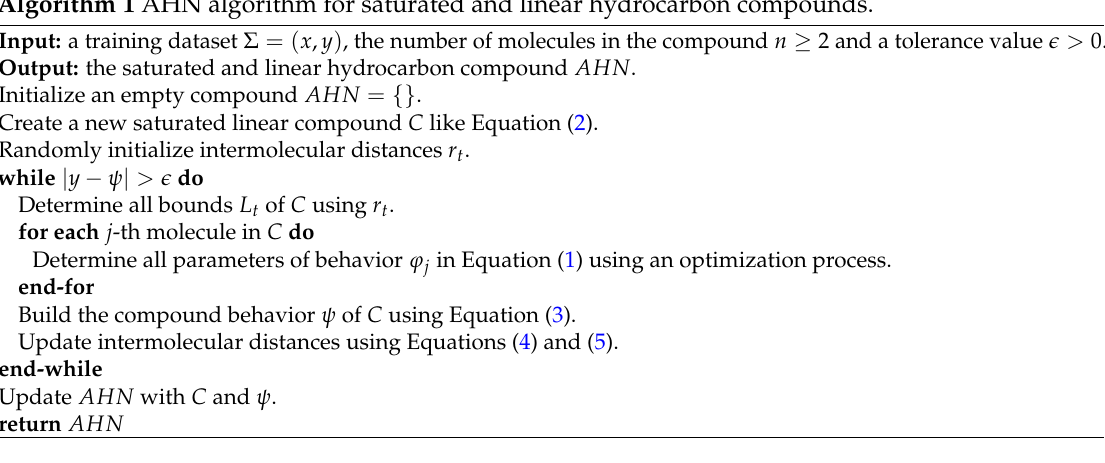
Figure 1. Structure of an artificial hydrocarbon network using saturated and linear chains of molecules [29]. For this work, the topology of the proposed classifier considers just one hydrocarbon compound (see Section 4). Algorithm 1 AHN algorithm for saturated and linear hydrocarbon